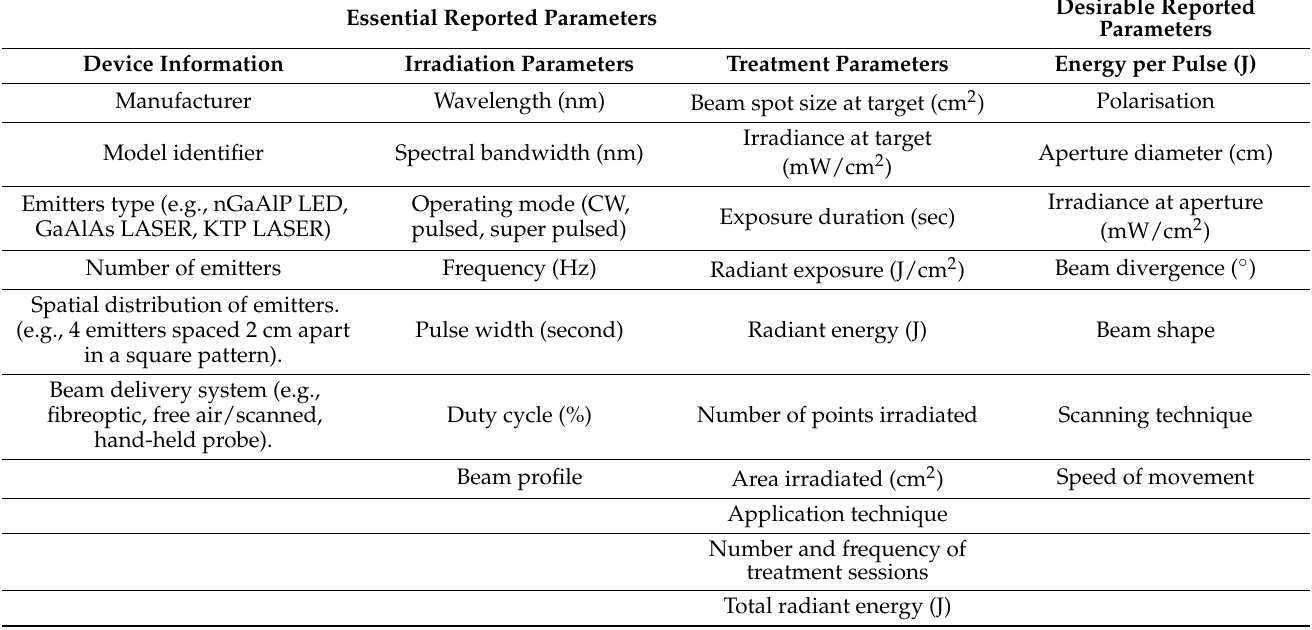
Table 2. The essential and desirable PBM parameters that should be reported to standardise the laser protocol for TMD patients, improve methodology reproducibility among clinicians and facilitate the comparison of results among researchers [136]. All the abbreviations in this table are listed in Supplementary File